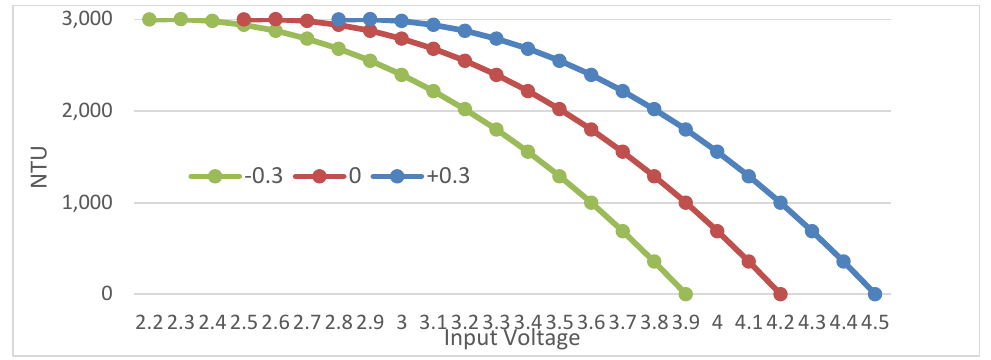
Figure 6. The Gravity turbidity sensor calibration curve with ±0.3 error.